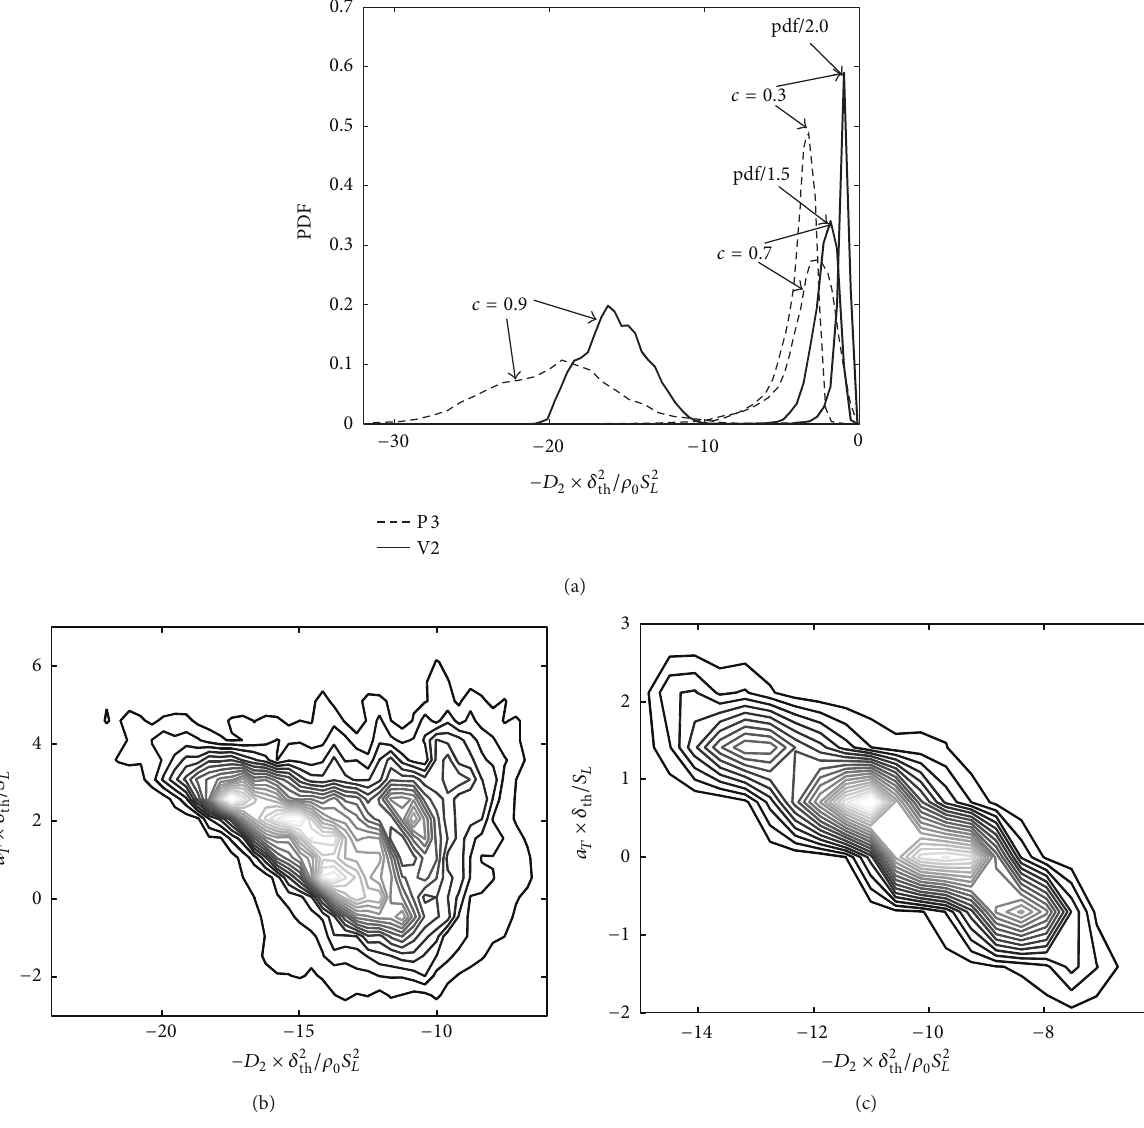
/𝜌 𝑆 2 𝑐 = 0.3 , 0.7, and 0.9 for cases (a) P3 and V2. Joint pdfs between (−𝐷 0 𝐿 for th